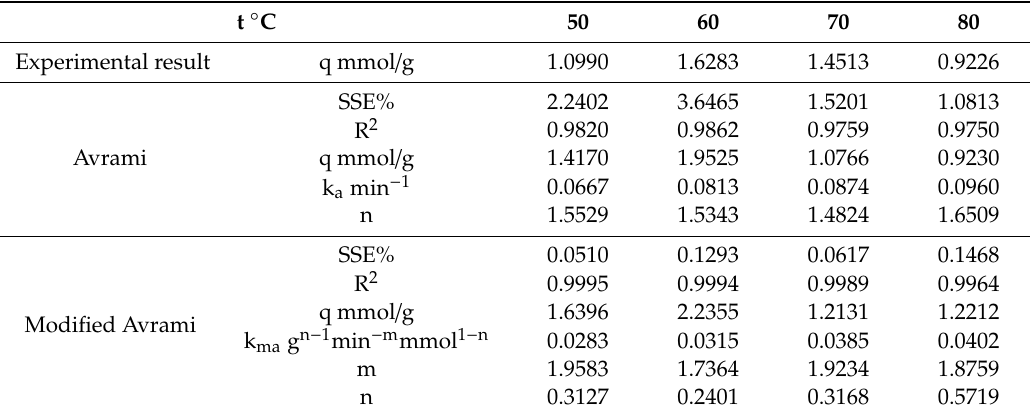
Figure 6. Adsorption characteristics and model fitting results at di ff erent temperatures. Table 4. Fitting parameters of experimental data under di ff erent temperature conditions